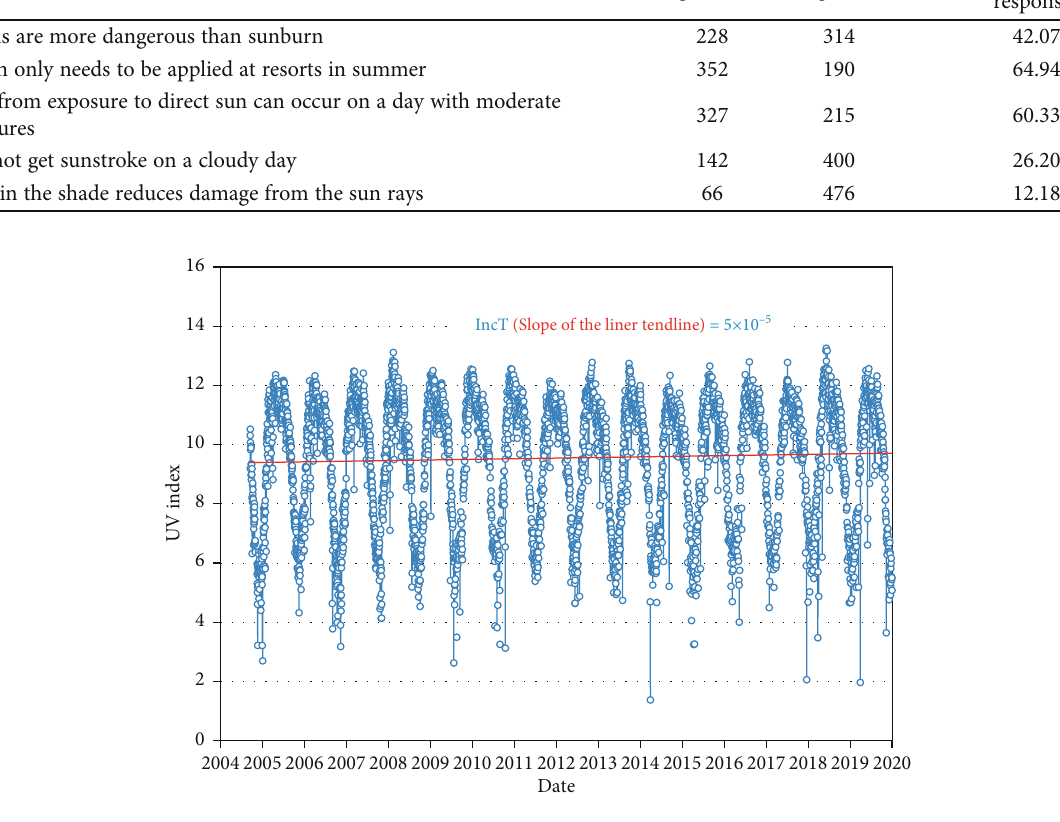
Figure 1: Time series variations in daily UVI at noon time on the campus of KAU during the study period. Table 2: Number and ratio of UVI in KAU during the study.